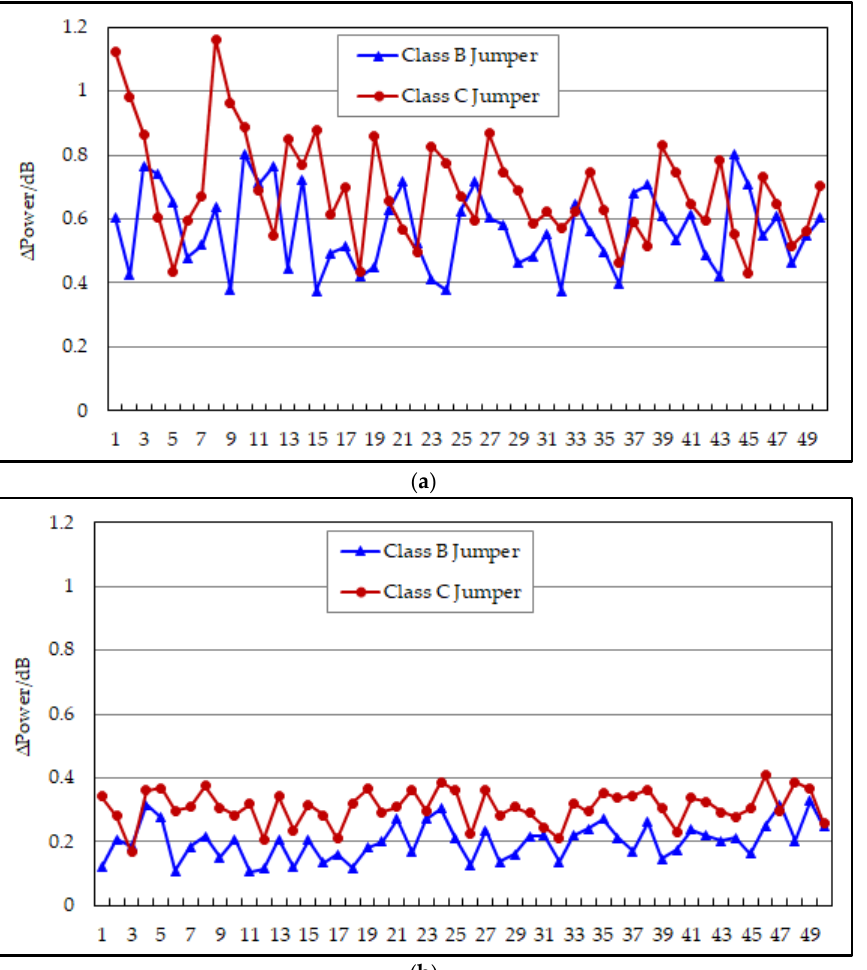
Figure 12. ( a ) is the data of TOSA with 2D coupling tested with different jumpers. ( b ) is the data of TOSA with 3D defocusing coupling tested with different jumpers. The horizontal axis represents the serial number of samples, and the vertical axis represents the power changing.